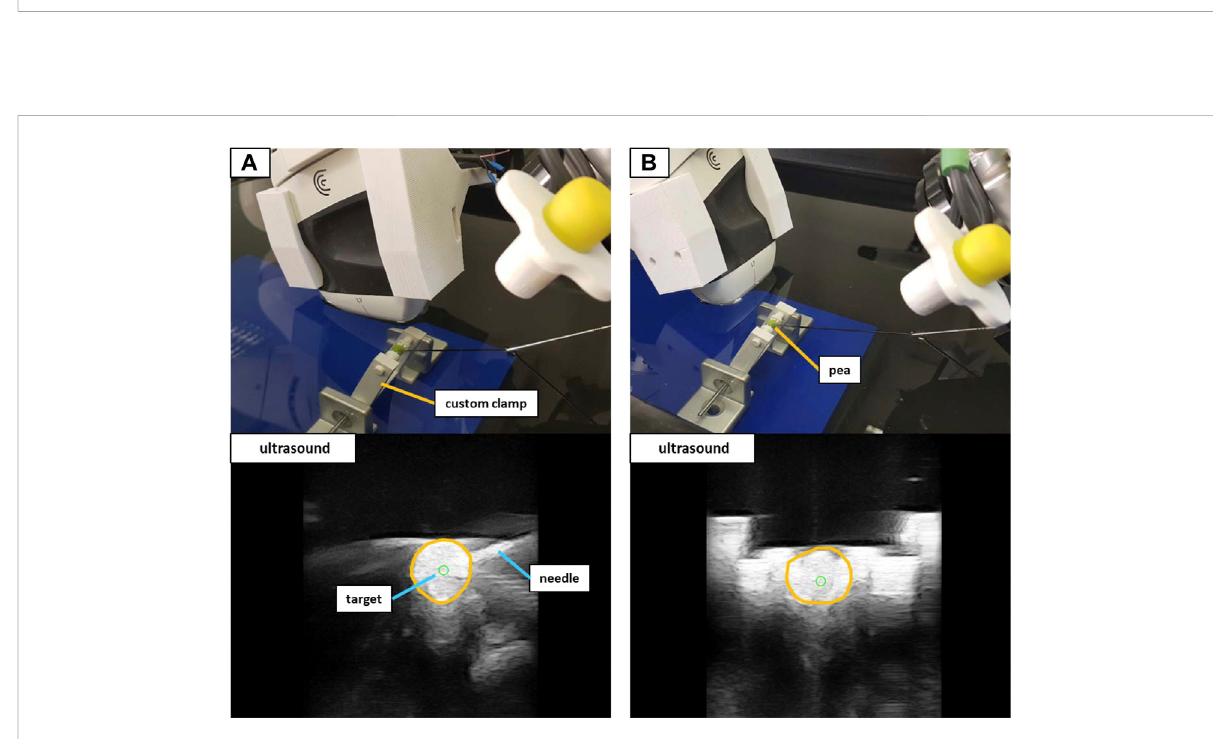
FIGURE 8 Theexperimentalsetuptotargetpeasinthewaterbath.Shownarethein-planepositioning (A) andorthogonalpositioning (B) oftheUSdevice. The orange circles in the US images outline the